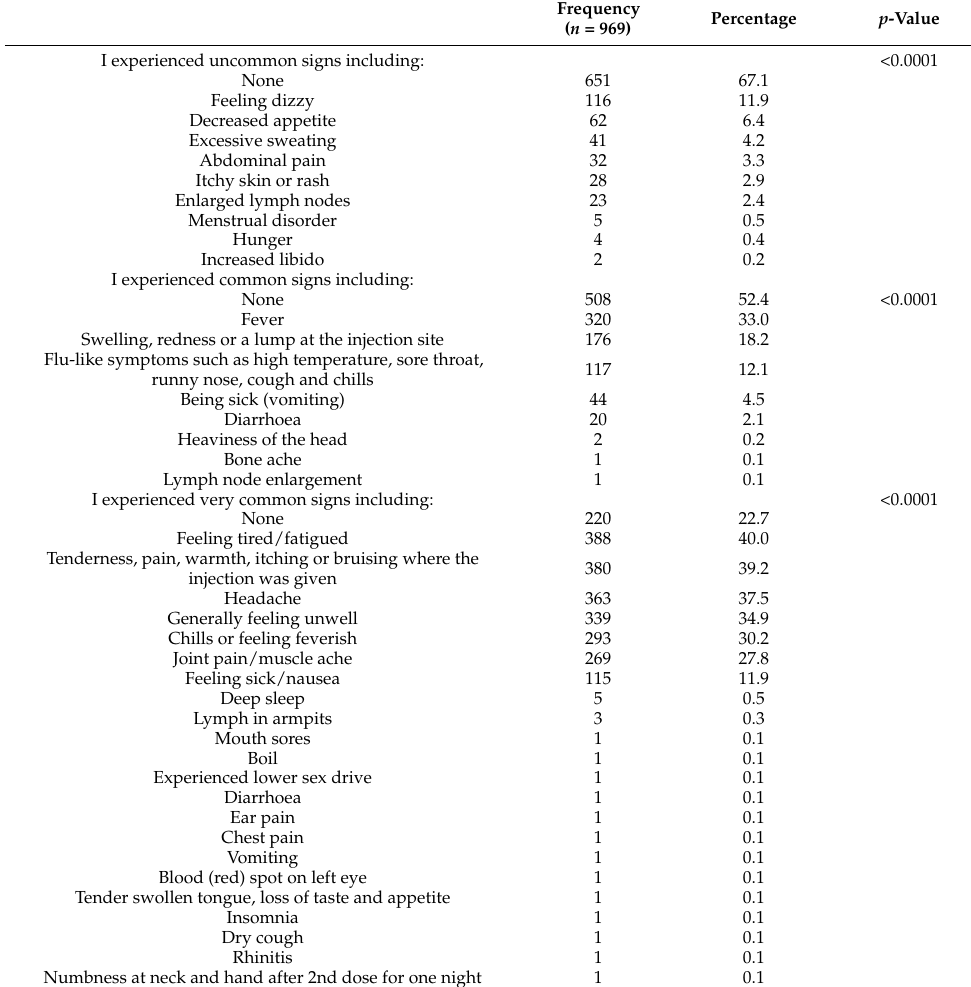
Table 7. Adverse events following COVID-19 vaccination among